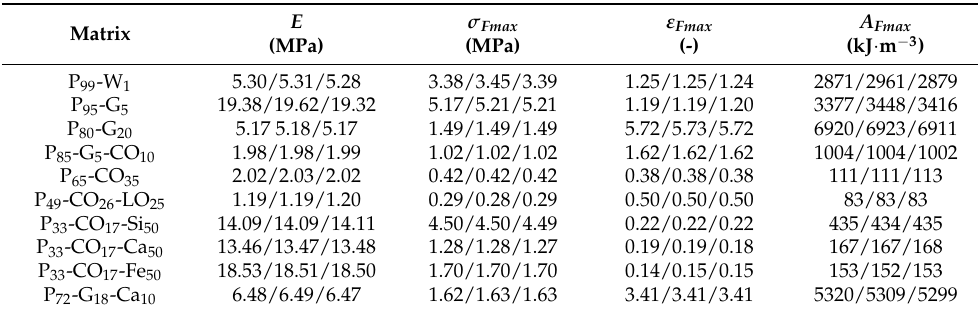
Table 4. Mechanical properties of theoretically nonporous matrices obtained by fitting of composite mechanical properties according to Equations (4) [33], (10) and (11).